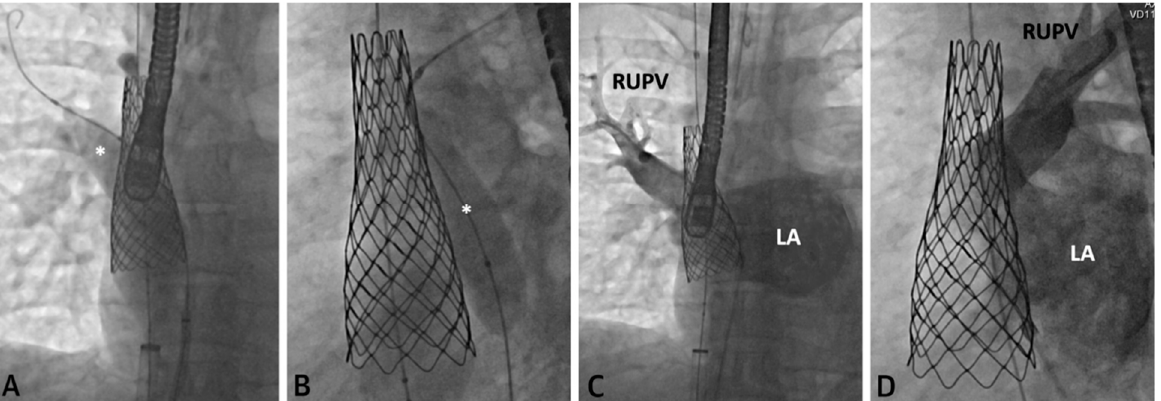
Figure 4. Series of fluoroscopy images depicting stent placement. An Atlas Gold Balloon (*) is placed in the RUPV to prevent obstruction during SVC covered stent deployment ( A , B ). Follow up hand injection angiogram in the RUPV demonstrates no residual narrowing and normal venous return ( C , D ). Revised from ref [4].